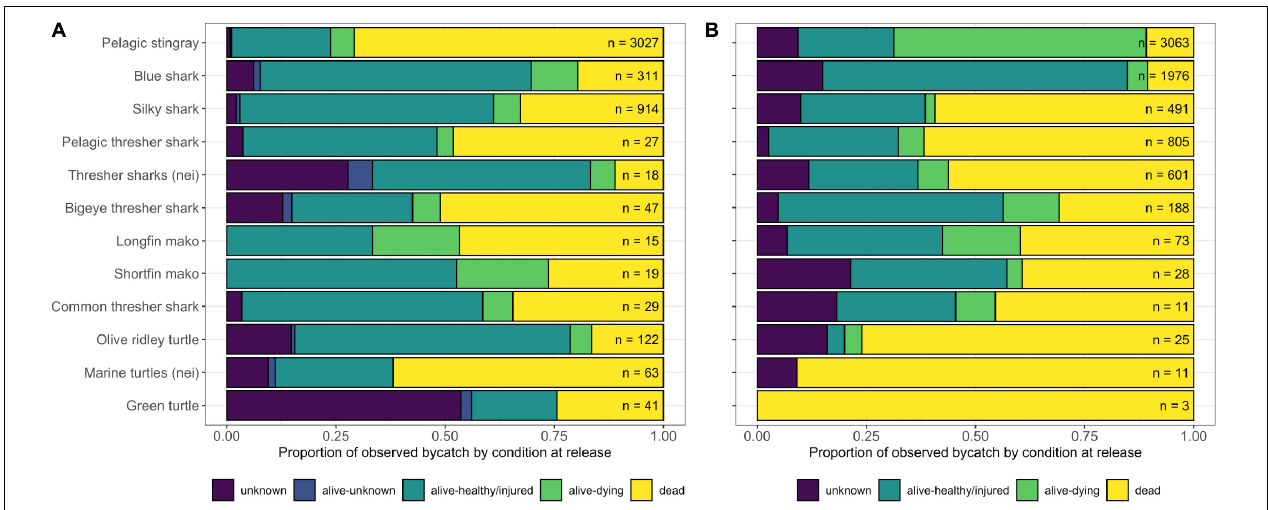
FIGURE 6 | Condition at release of selected Species of Special Interest (SSI) as a proportion of total observed catch ( n = ) of each species or taxon as recorded by observers in panel (A) the LBF and (B) the DWF. Species with at least 40 records were included. Nei (not elsewhere indicated) was used for individuals that were not identified to species